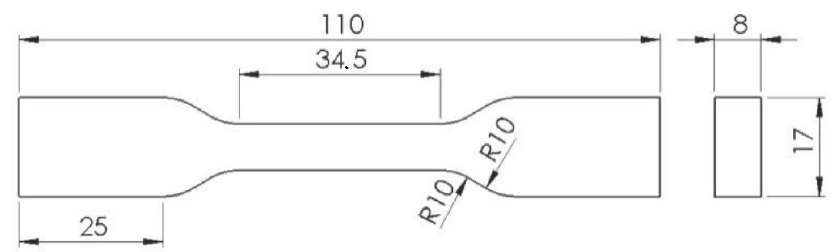
Figure 3. Specimens for tensile strength testing.